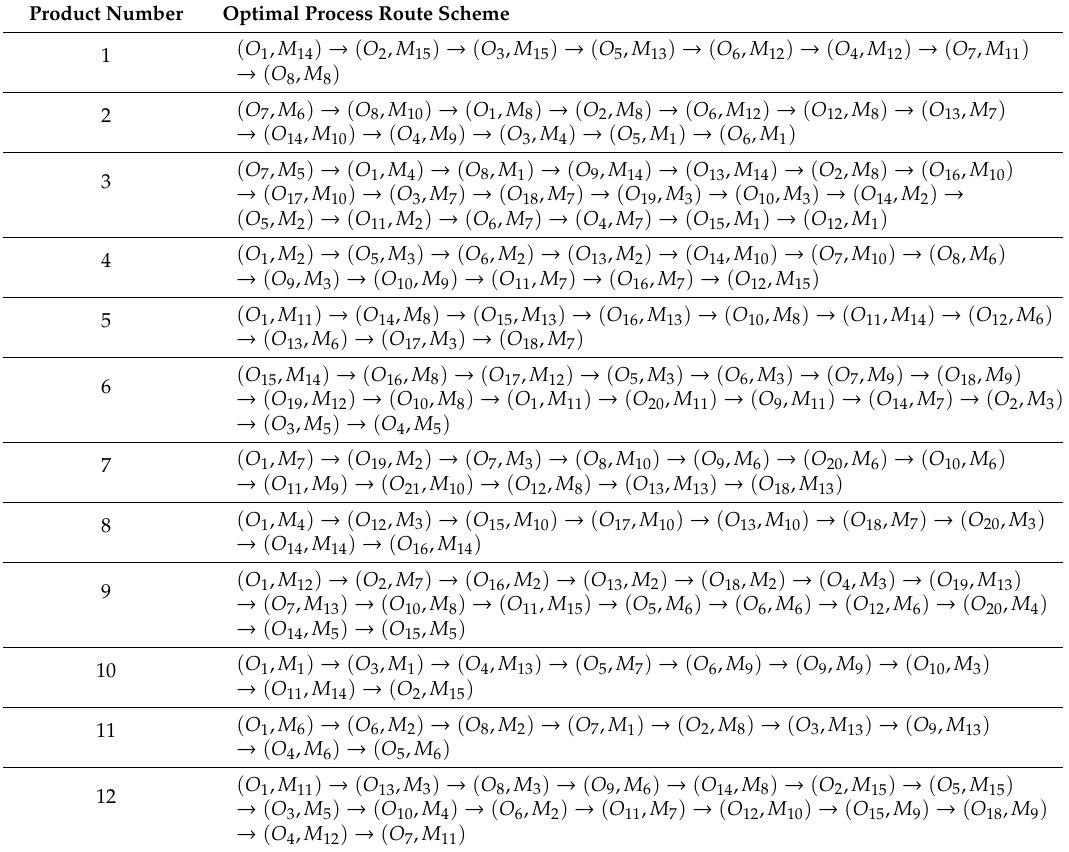
Table 8. The optimal process route plan for each product of case